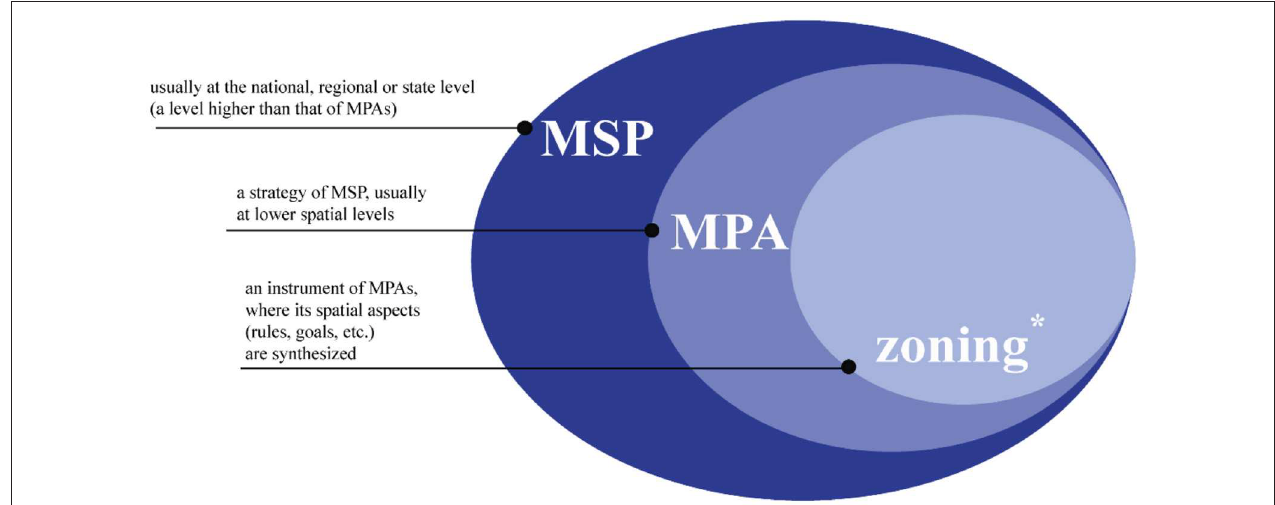
FIGURE 1 | Relationship between key concepts in marine, area-based management. *MPA zoning, where some aspects of management are spatially identified, should be distinguished from ocean zoning, where strategies, such as MPAs, and sectoral activities are spatially regulated at higher levels. Zoning applies to the management of MPAs based on the International Union for the Conservation of Nature (IUCN) categories. The diagram is based on the literature and concepts presented in this